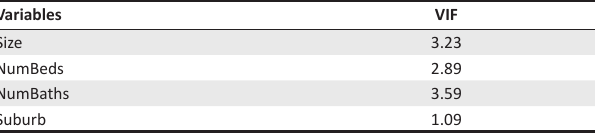
TABLE 3: Variance inflation factor results. Variables